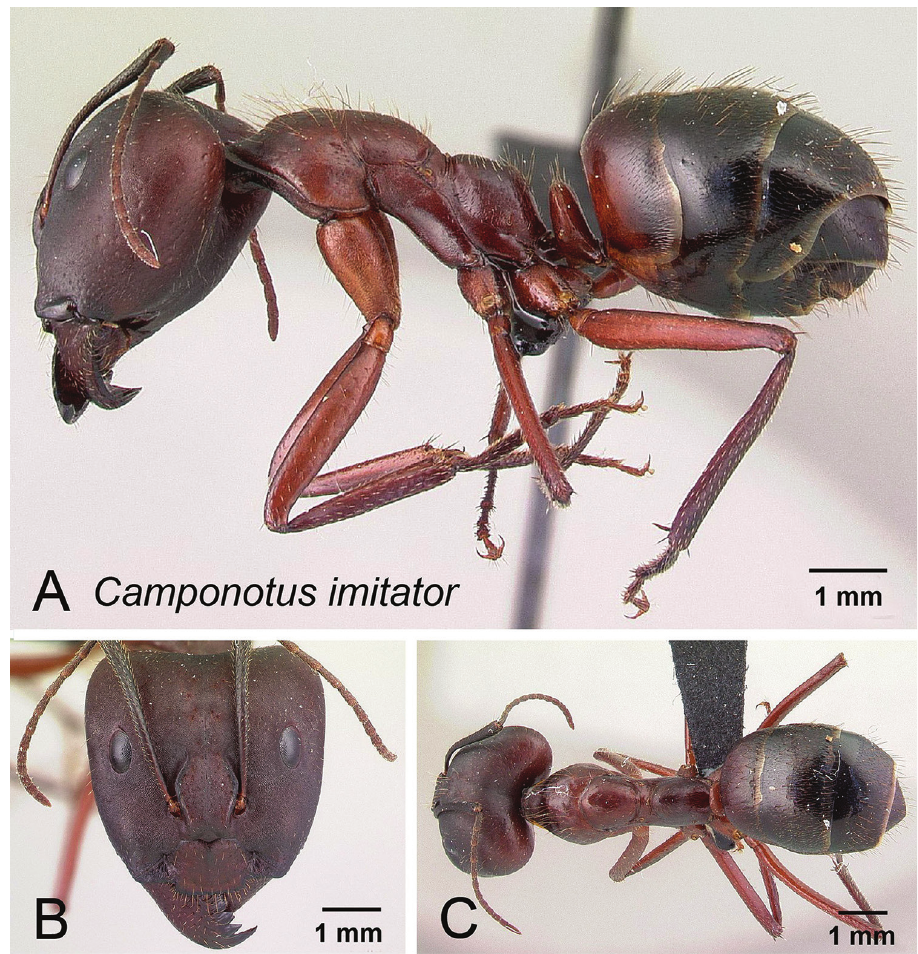
Figure 10. Camponotus imitator major worker CASENT0452863. A Lateral view B Head in full-face view C Dorsal